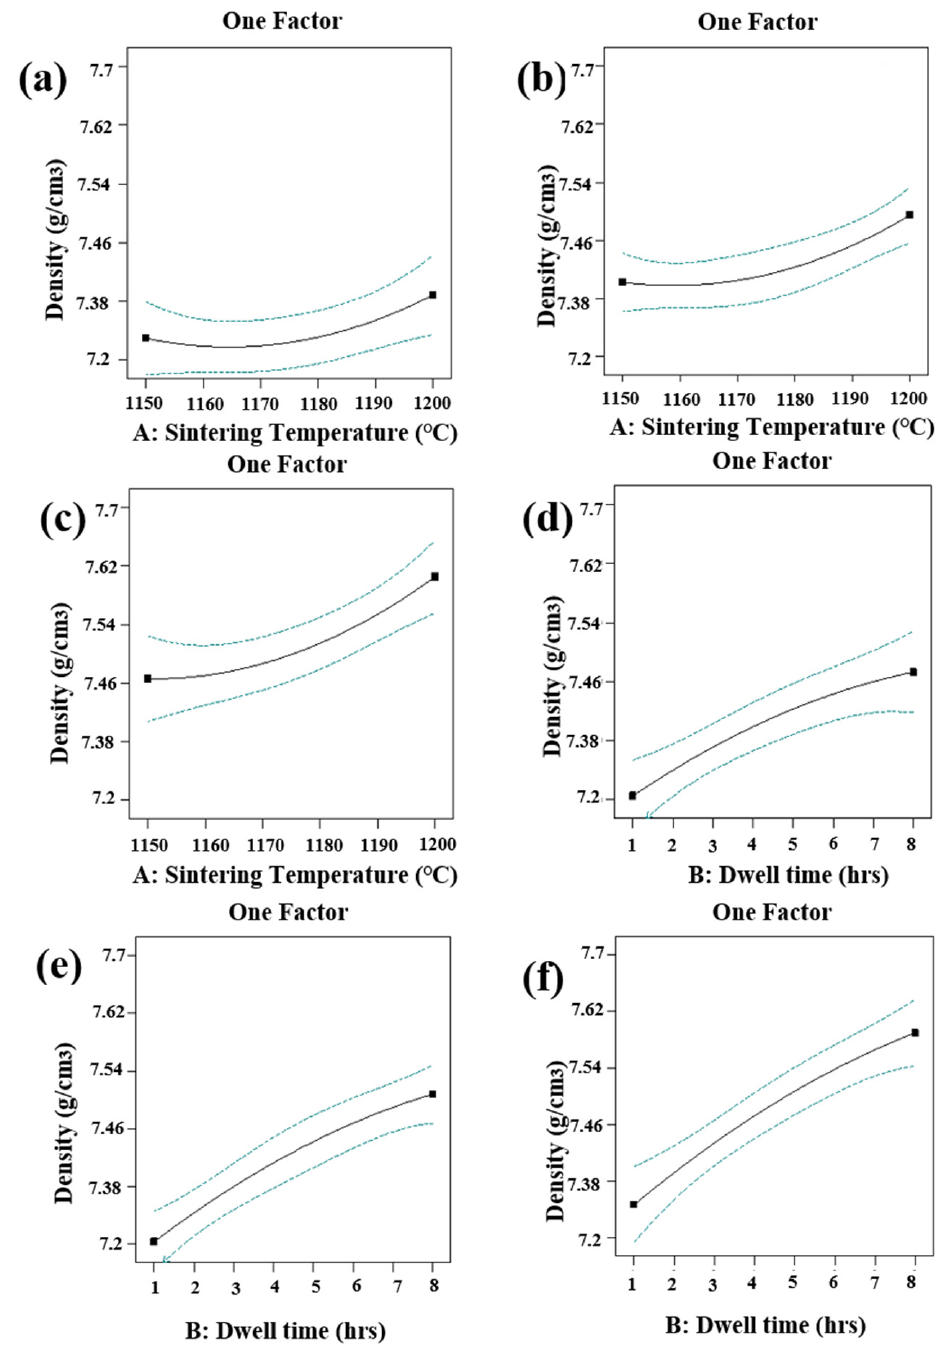
Figure 13. One factor effect plot for density.